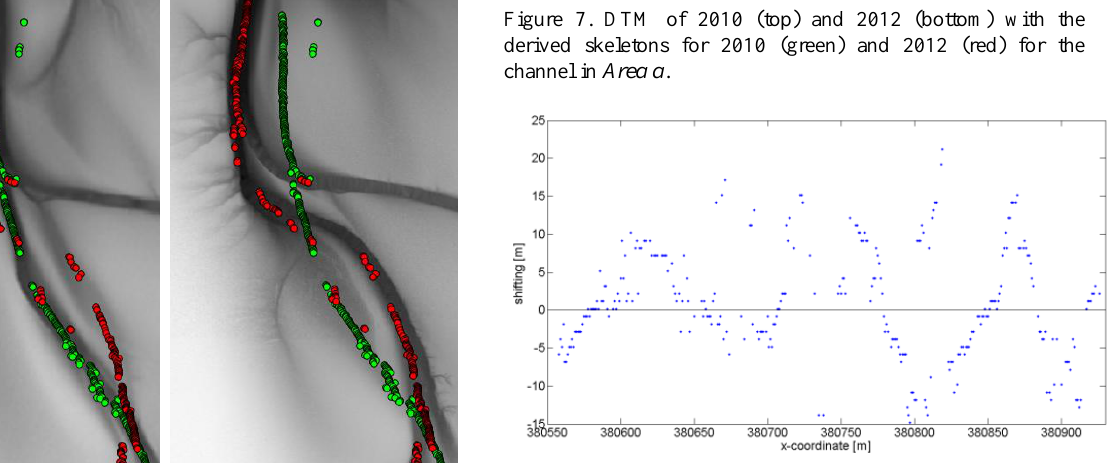
Figure 5. DTM of 2010 (left) and 2012 (right) with the derived skeletons for 2010 (green) and 2012 (red) for the main channel.